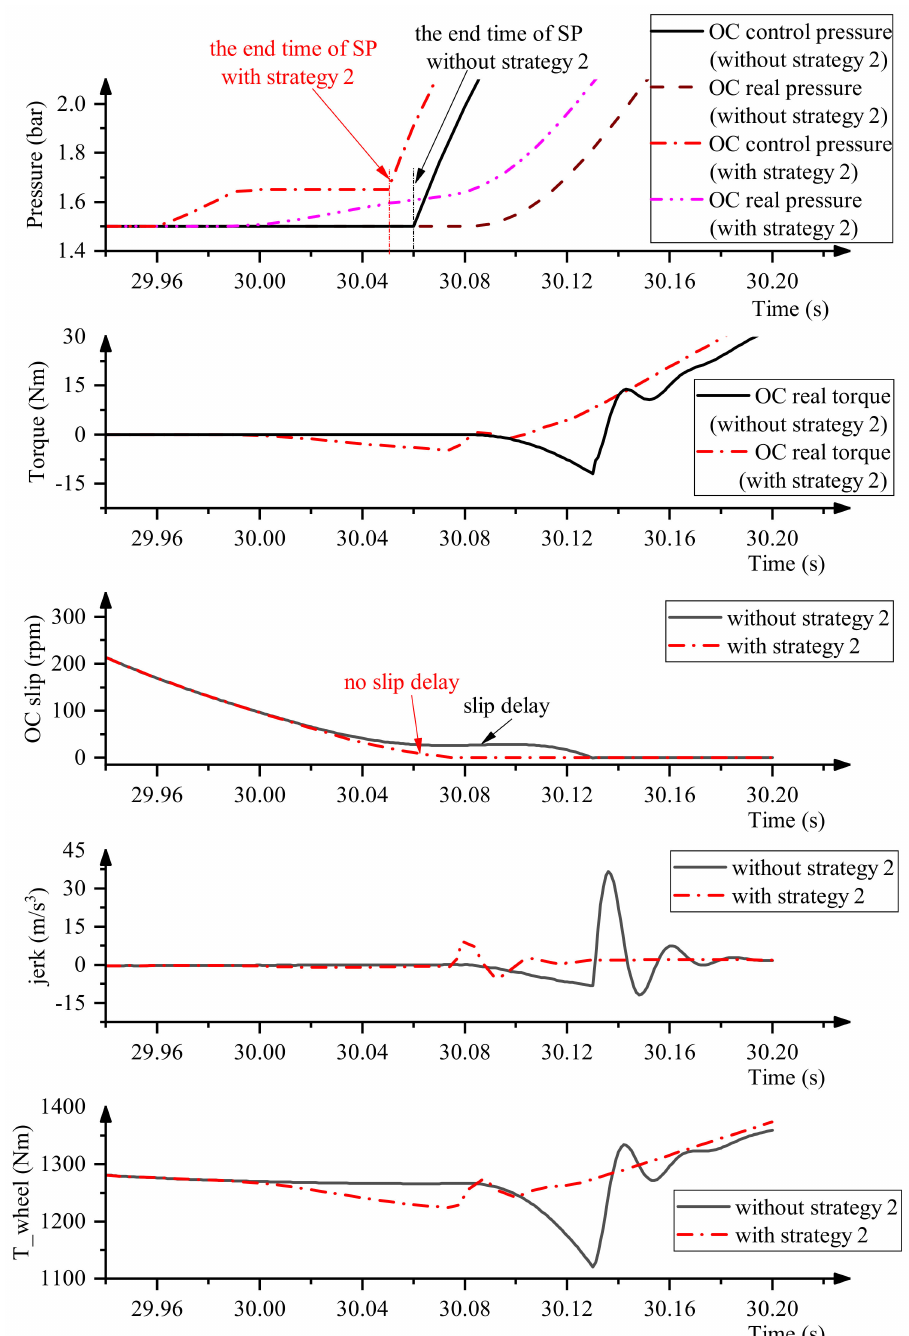
Figure 14. Comparison of two shifting processes with and without strategy